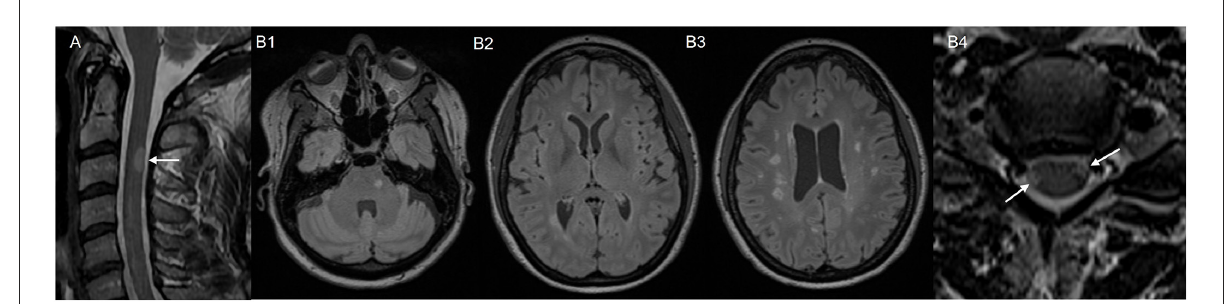
FIGURE1 MRI images of two representative Mayo clinic cases. Case 1 with post-TNFI myelitis: (A) MRI cervical spine, sagittal T2 sequence, showing T2 hyperintense lesion in the posterior spinal cord at C3. Case 2 with post ICI-myelitis: (B1–B3) MRI brain, axial T2 fluid-attenuated inversion recovery (FLAIR) sequence, obtained prior to immune checkpoint inhibitor treatment showing multiple white matter T2 hyperintensities suggestive of demyelination. (B4) MRI cervical spine, axial T2 sequence, obtained after immune checkpoint inhibitor treatment, showing two spinal cord lesions suggestive of demyelination